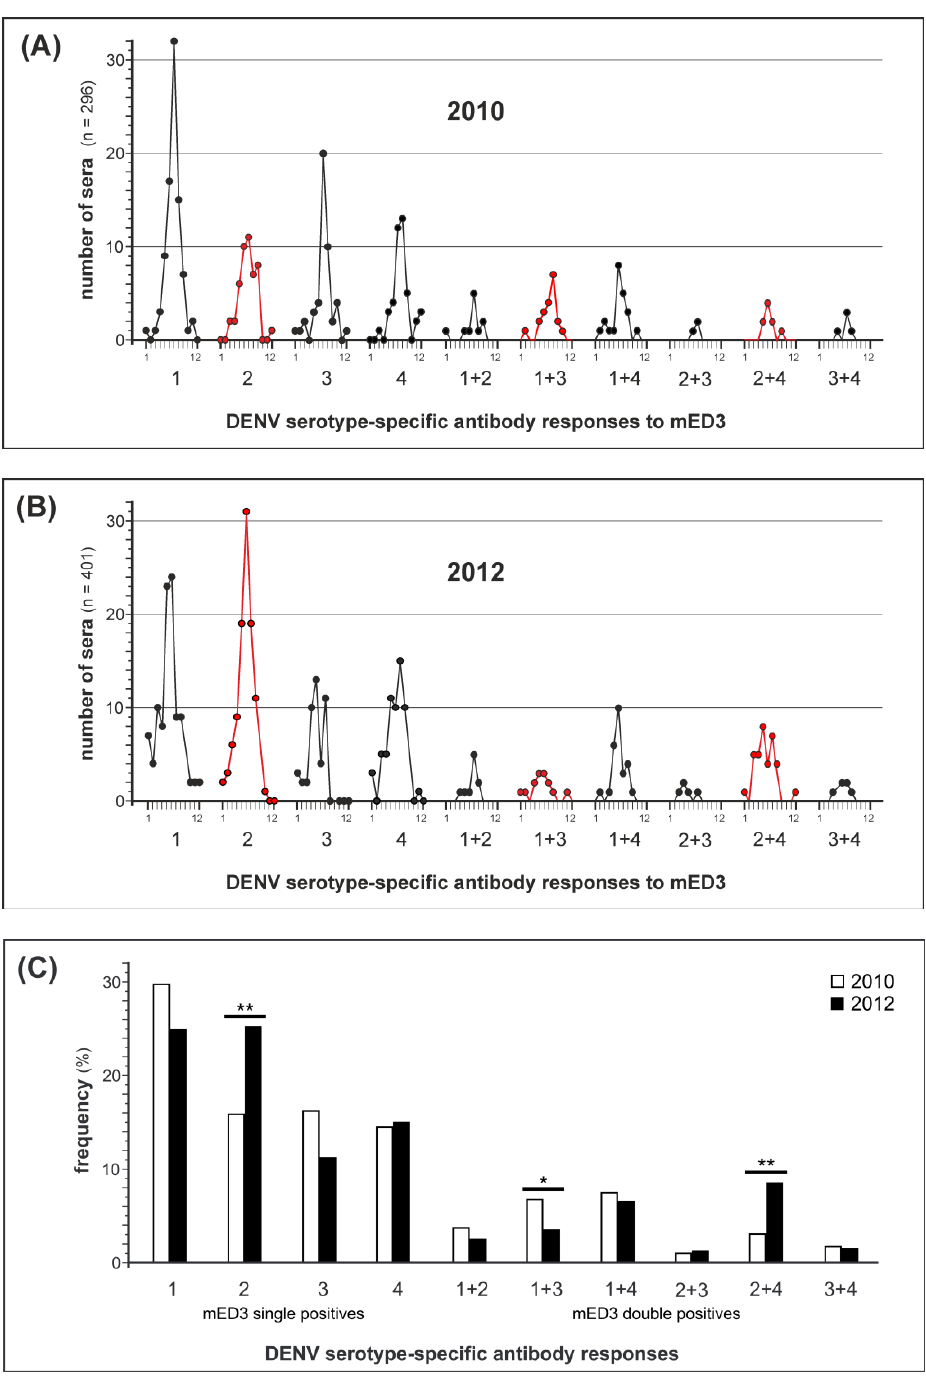
Figure 6. Results of the retrospective seroprevalence study. ( A ) ED3 dot assay results in 2010 given per month (1 – 12). Sera were all tested mED3 dot single- ( n = 226) or double-positive ( n = 70) and are a subset of the sera ( n = 296) as shown in Figure 5B ( n = 924). ( B ) ED3 dot assay results in 2012. Sera were tested single- ( n = 306) or double-positive ( n = 95) and are a subset ( n = 401) of sera shown in Figure 5B ( n = 924). Red circles, sera positive for DENV-2/1 + 3/2 + 4 that show significant changes in serum numbers. ( C ) Frequency of DENV serotype-specific antibody responses in 2010 and 2012. Frequencies were calculated based on the numbers of positive sera as shown above in Figure 6A and 6B. White bars, frequency of serotype-specific antibody responses detected in 2010. Black bars, frequencies detected in 2012. Significant differences were calculated using a 2-tailed z-test and are labeled by asterisks (* p = 0.047, ** p = 0.003).